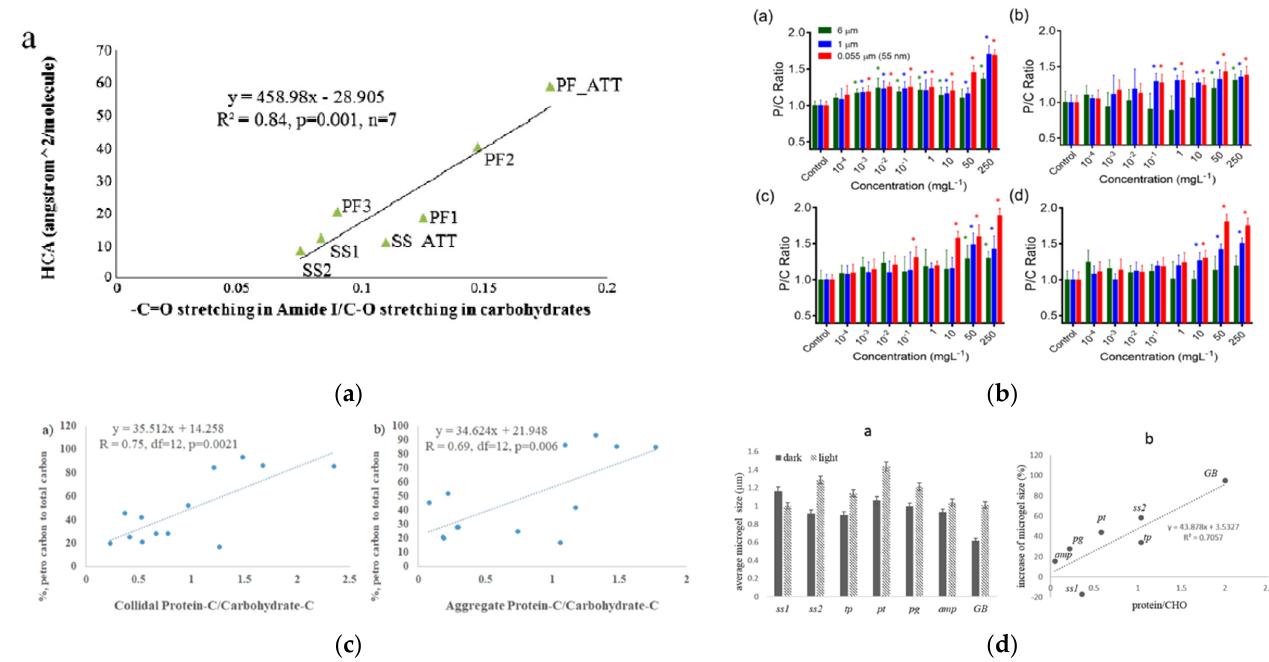
Figure 1. ( a ) Examples for the relative hydrophobicity of EPS that increases with P/C ratio ( [20] , with permission of the publisher), ( b ) the relationship between nanoplastics concentration and the size-dependent induction of EPS with higher P/C ratio ( [19] , with permission of the publisher), ( c ) the relationships of % petro-carbon to total carbon in colloidal or sinking aggregates that increase with the P/C ratio of EPS ( [34] , with permission of the publisher), and ( d ) the microgel size increase due to light-induced ROS chemical crosslinking of proteins in EPS that scale with their P/C ratio ( [35] , with permission of the publisher).